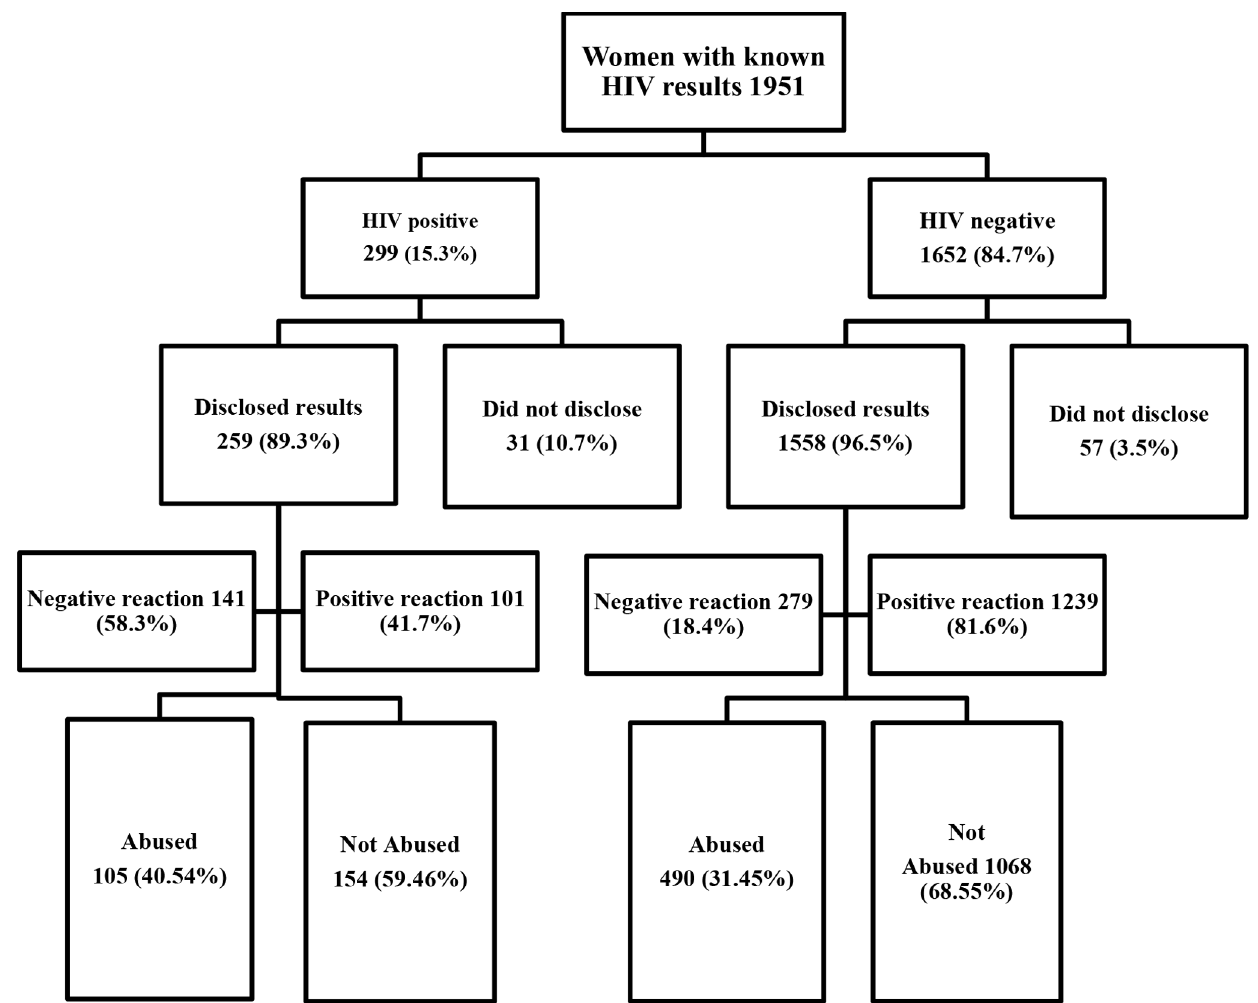
Figure 1. Prevalence of intimate partner violence (physical, sexual or emotional) after testing and disclosing HIV status to a partner (%).